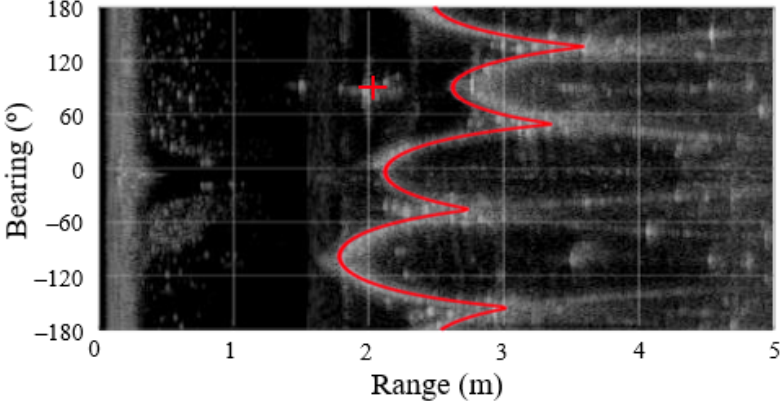
Figure 13. Overlap of acoustic image with ground-truth information, to define the boundary between regions of true-positives (left side) and false-positives (right side). The expected positions of the tank walls and floater are marked in